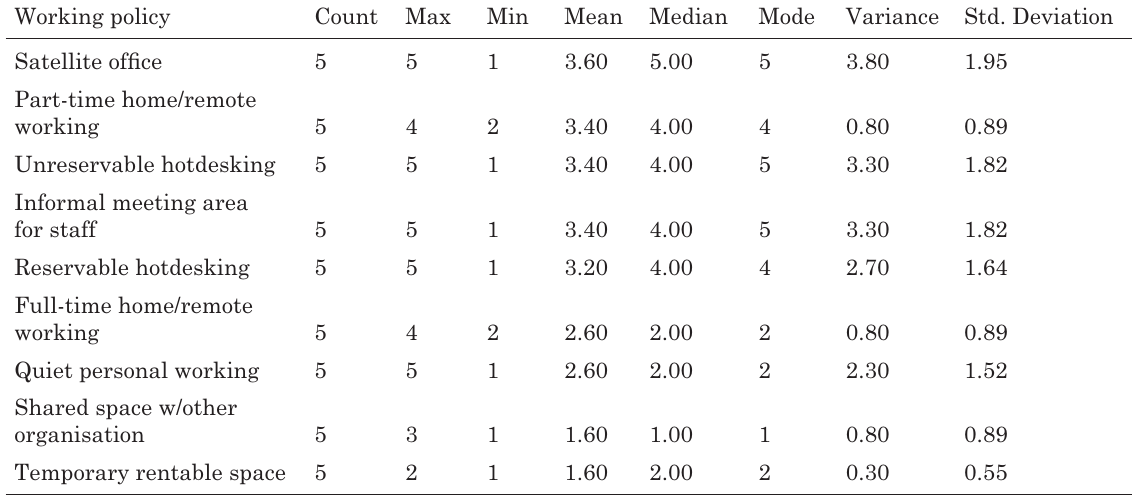
Table 6. Implementation of altenative working policy Working